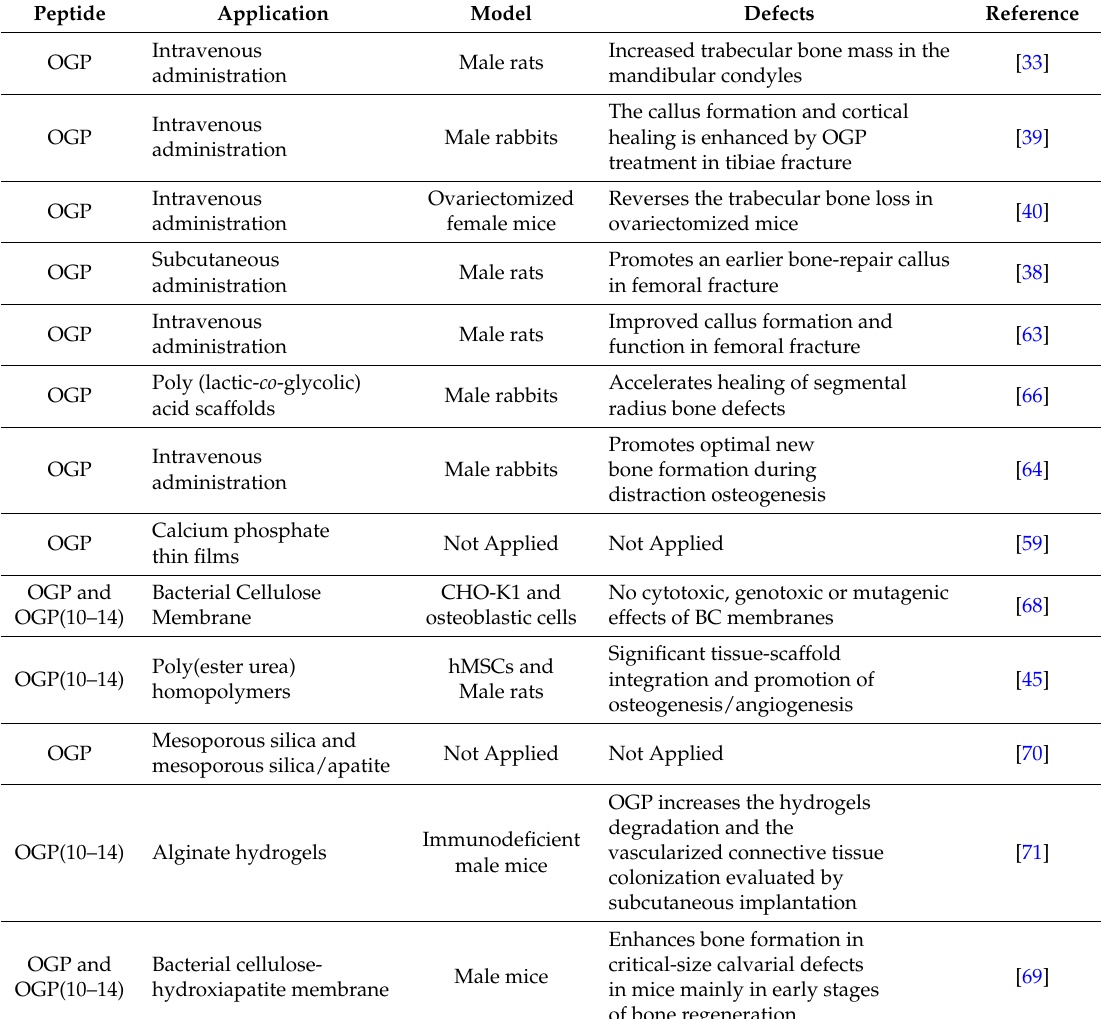
Table 3. Medical applications of OGP and OGP(10–14)